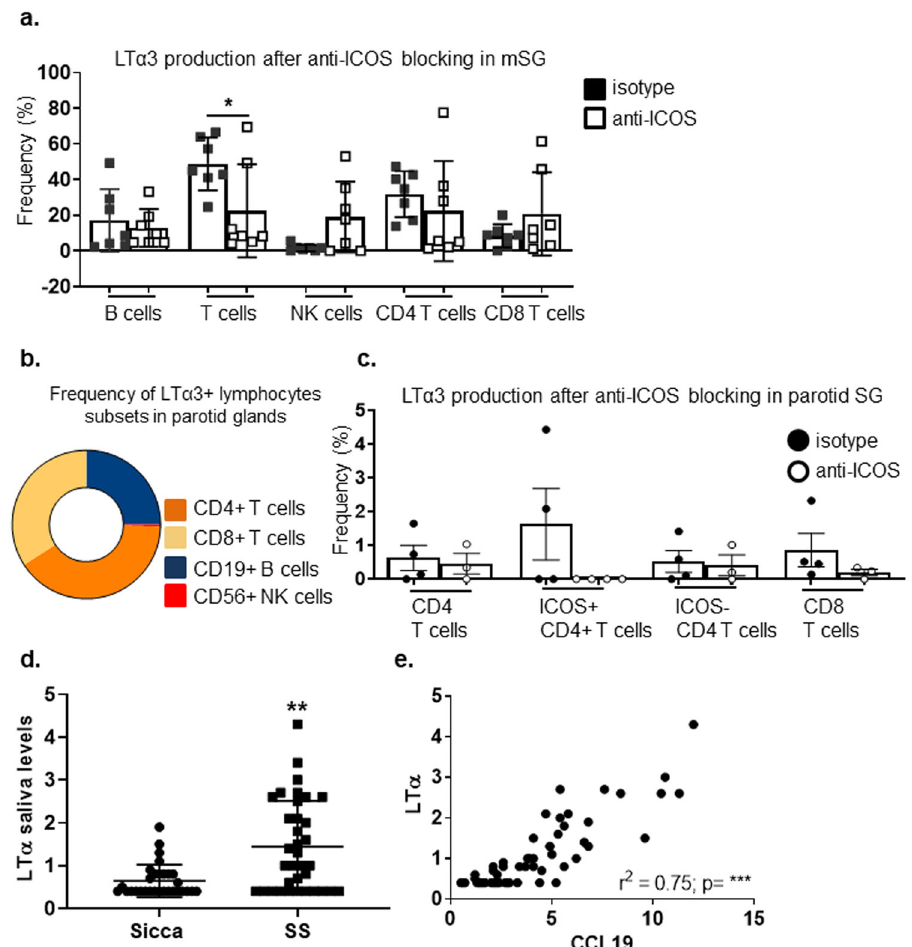
Fig. 5 ICOS-ICOSL interaction in fl uences LT α 3 production in the salivary glands of patients with Sjogren ’ s syndrome and MALT lymphoma. a Graph showing frequency of LT α 3 producing lymphocyte populations in mSGs biopsies ( n = 7) treated with anti-ICOS (white squares) or as compared isotype antibody (black squares) treatment ex vivo. * p < 0.05, Mann – Whitney test. Data are representative as mean ± s.d. b Diagram showing LT α 3 producing lymphocyte populations in MALT-parotid SG biopsies. c Graph showing percentage of LT α 3 producing lymphocyte populations in MALT-parotid SG biopsy treated ex vivo with anti-ICOS (white circles) or as compared isotype antibody (black circles). Data are representative as mean ± s.d. d Graph showing saliva levels of LT α in sicca and Sj ӧ gren syndrome patients. ** p < 0.01, Mann – Whitney test. Data are representative as mean ± s.d. e Graph showing linear regression analysis to con fi rm correlation between LT α and CCL19 detected in saliva of Sj ӧ gren channel spanned the 0 – 255 scale optimally. The LSM510 Image Examiner Software was used to process these images.